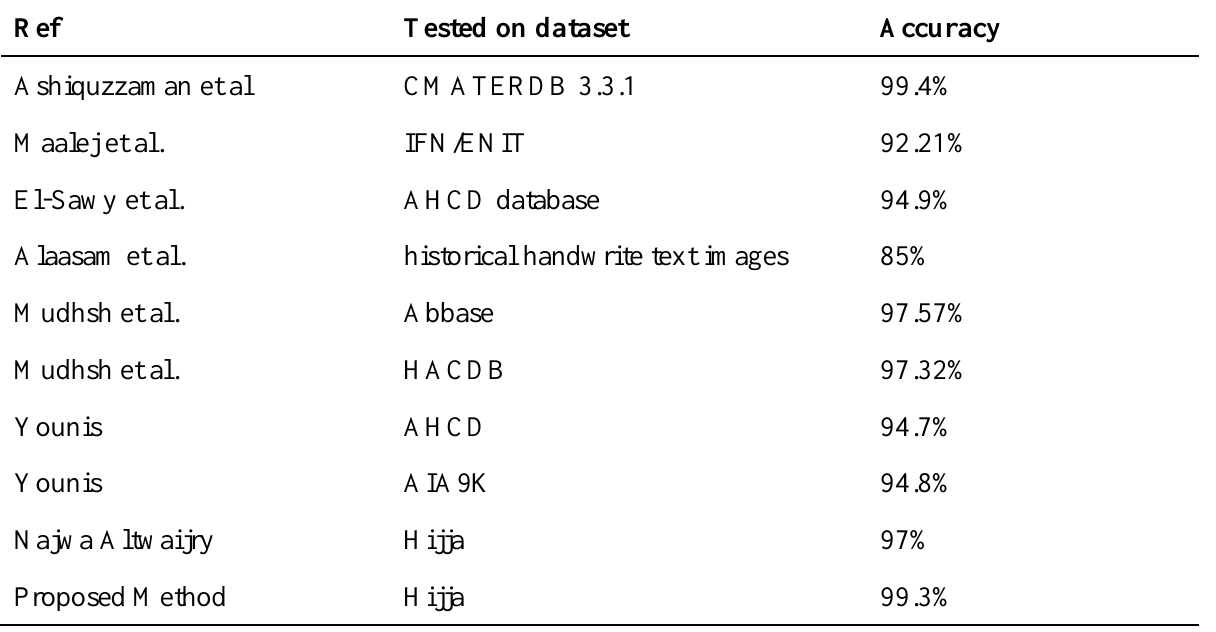
Table 4. Handwriting recognition models using deep learning